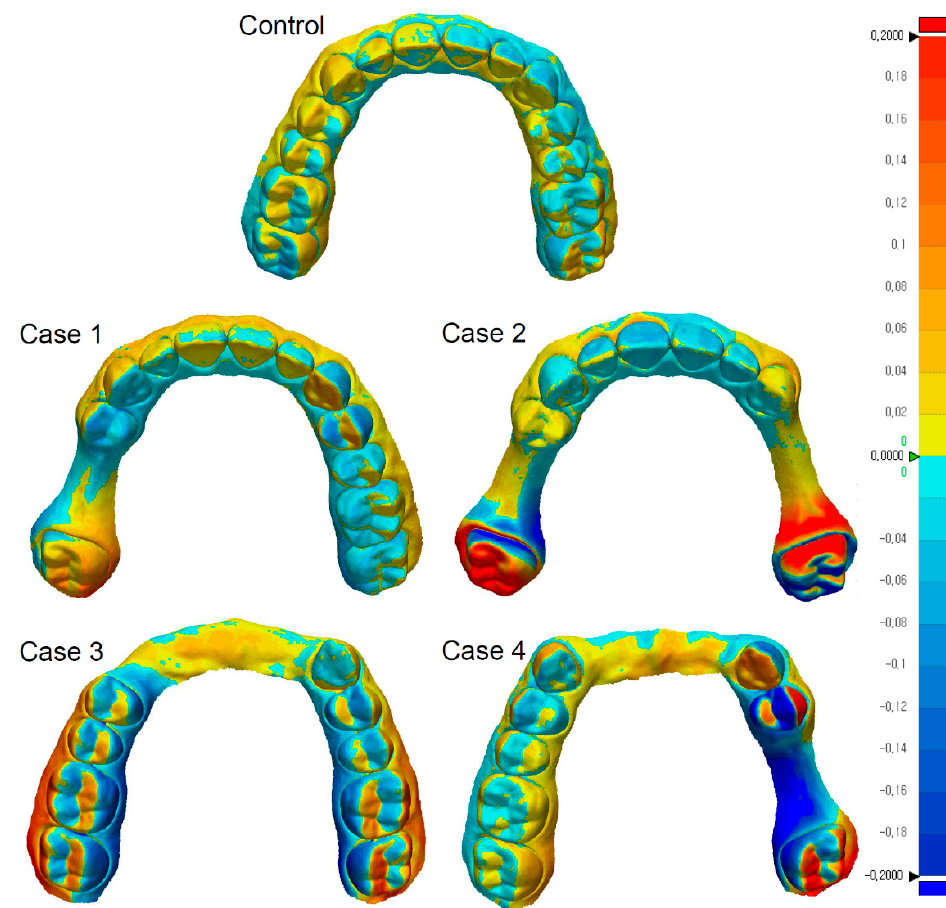
Figure 3. Representative images from a color map for assessing precision. The color maps for the CS3600 datasets are displayed to visualize the distribution of deviation. Deviation sites are mainly observed on the side that includes the partially edentulous area.